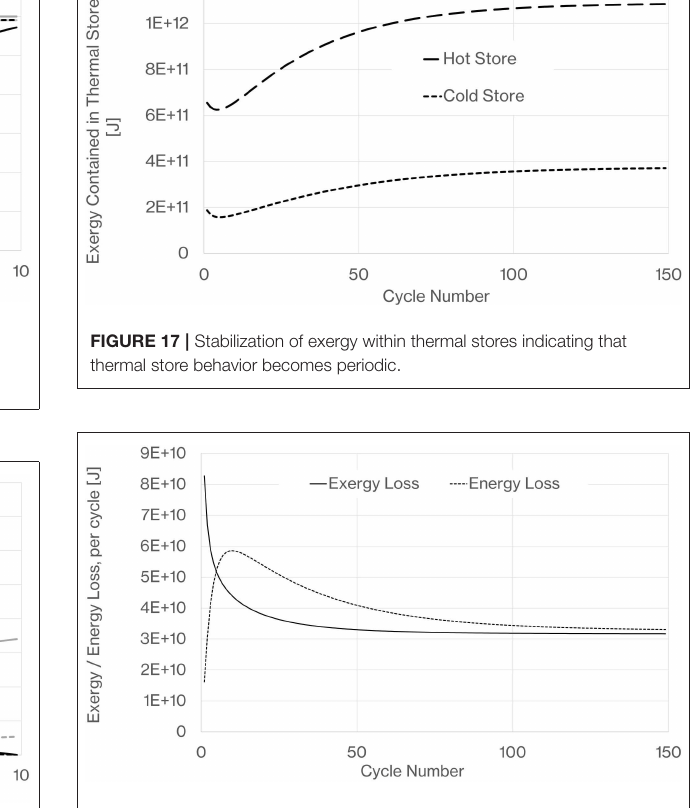
FIGURE 18 | Exergy loss from both thermal stores and complete system energy loss per cycle, Ideal cycle i.e., compressor and expander isentropic efficiencies = 1, heat exchange effectiveness = 1 and heat exchanger pressure drops =